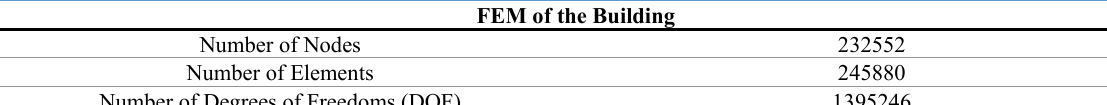
Table 1 C haracteristics of the developed building finite element model.